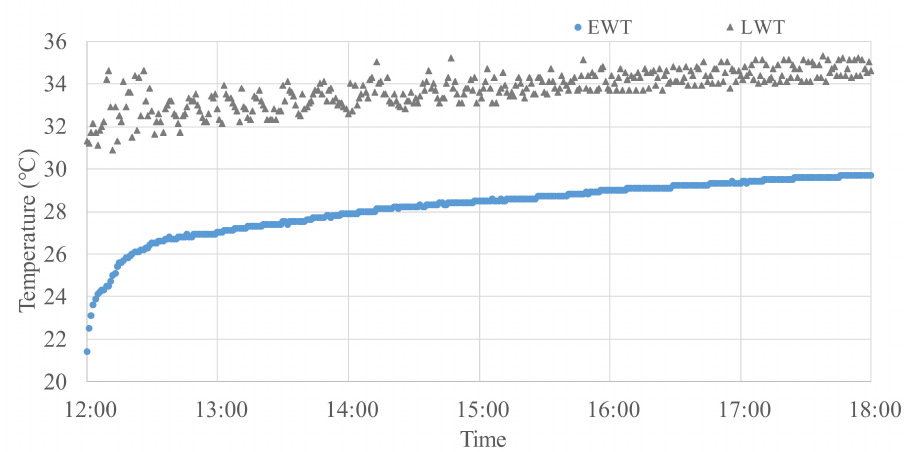
Figure 12. Fluctuation of EWT and LWT in Case 4. Figures 13 and 14 show EWT, LWT, and the average hourly HER for Cases 5 and 6. In Case 5, the flow rate was set to 30 LPM (from 23 June to 3 July 2020), while in Case 6, the flow rate was set to 80 LPM under the same conditions (from 7 to 17 July 2020).